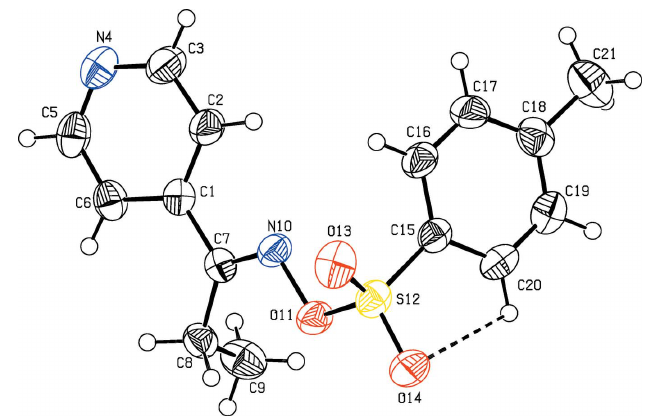
Figure 1 Molecular structure of the title compound with the atom labelling and